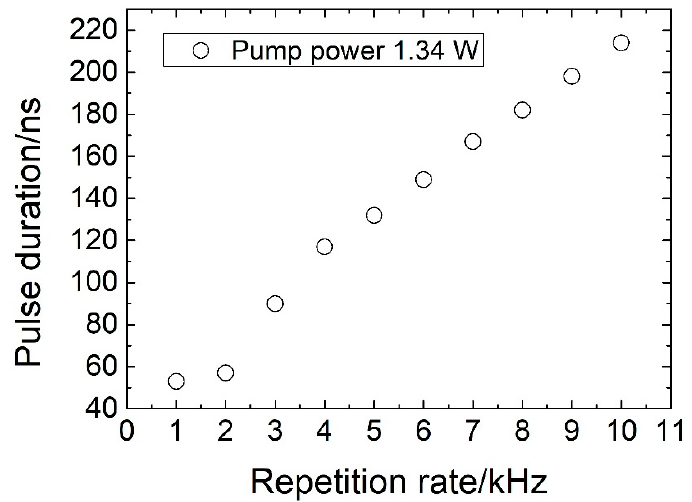
Figure 8. Evolution of the pulse duration as a function of the repetition rate for a launched pump power of 1.34 W. The fiber length used in this experiment was L = 1.1 m.